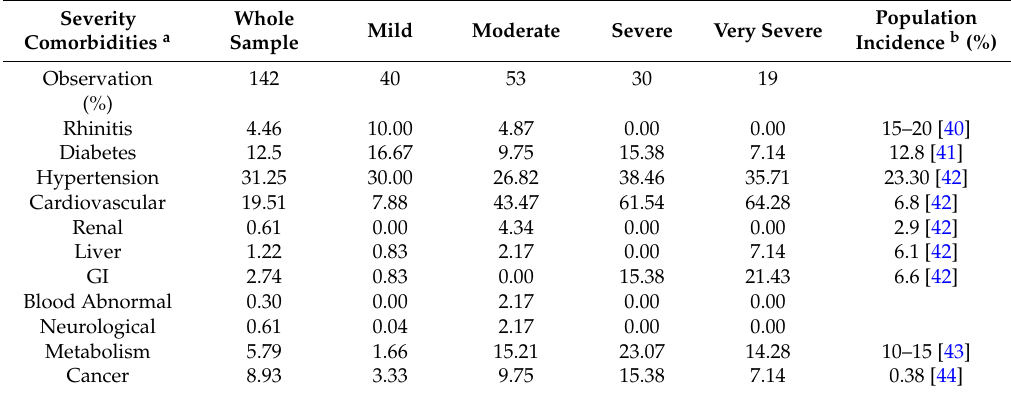
Table 2. Statistical summary of comorbidity incidence rates.